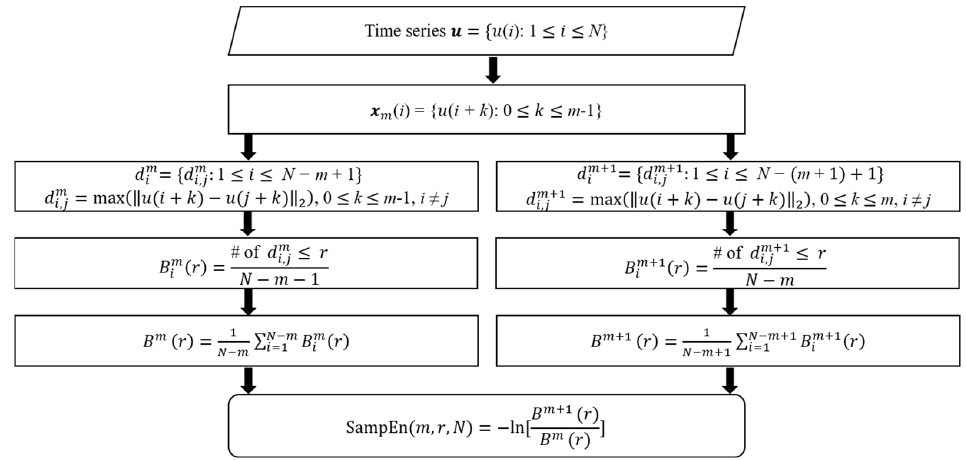
Figure 3. Flowchart of SampEn calculation. N : the time series length. m : the sequence length to be compared. r : accepting matches tolerance.